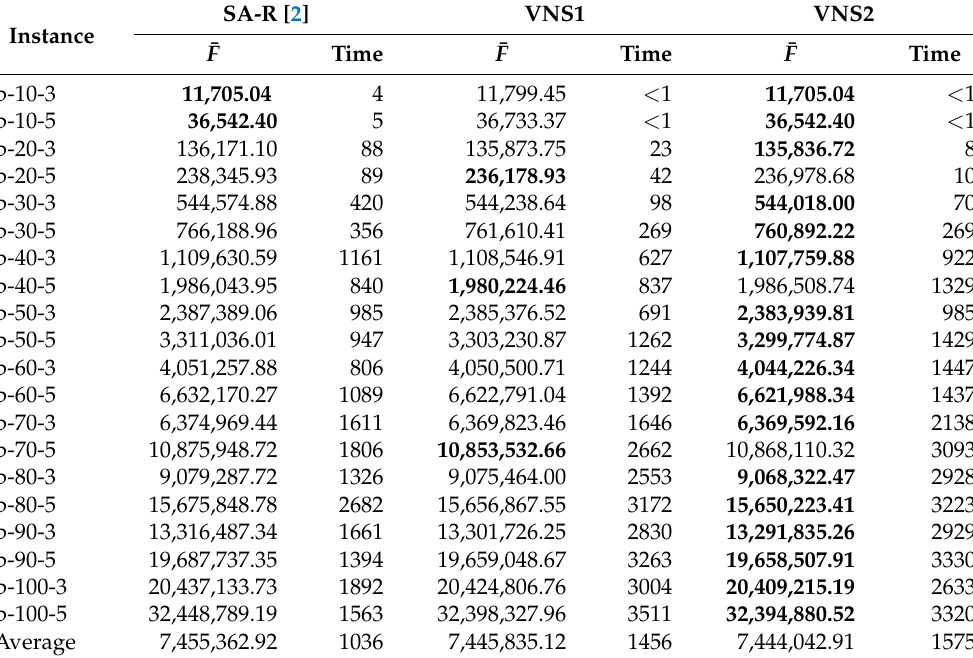
table. The superiority of VNS over SA-R is also evidenced by the statistics presented in the last row of the tables, where we show the averaged results for each algorithm. Table 3. Average results of VNS1, VNS2, and SA-R for smaller sized instances (the time is in seconds).